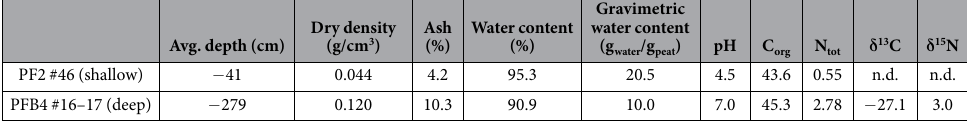
Table 6. Main physical and chemical properties of the two peat samples (data from 5 ).